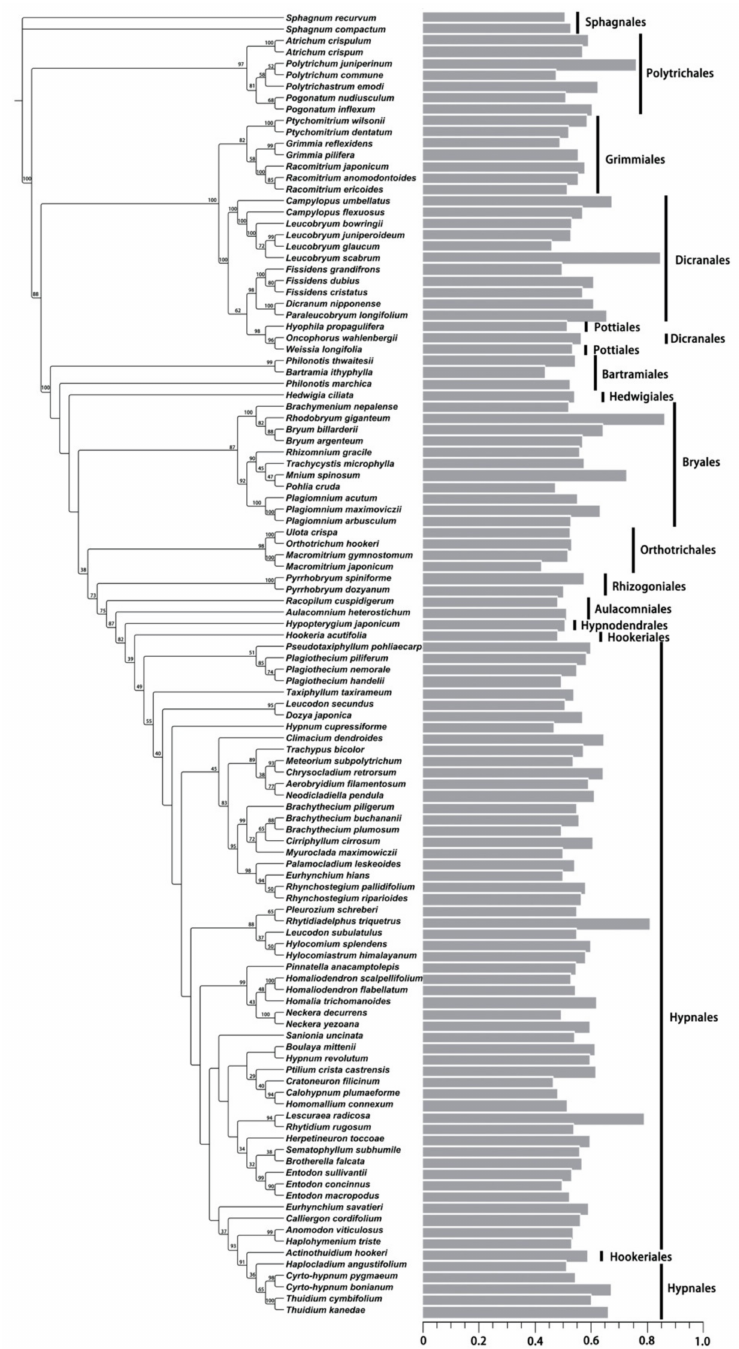
Figure 5. Phylogram of 112 moss species with the average DNA 1C value for each species plotted and the moss orders indicated with vertical bars. The maximum likelihood bootstrap values are labelled above the